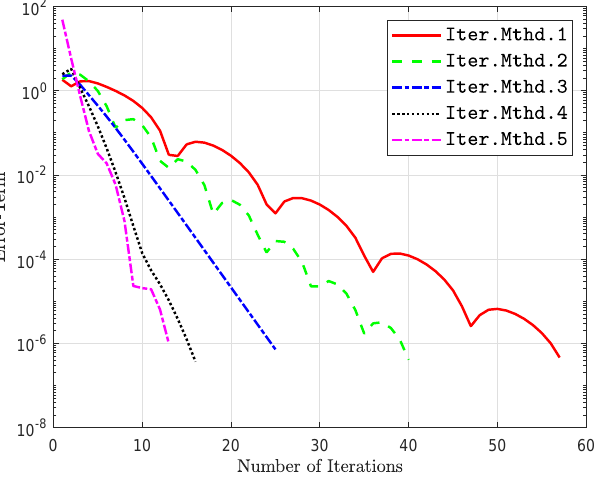
Figure 15. All techniques are computationally examined while s 0 = ( 6, − 1,5, − 4,1 ) T